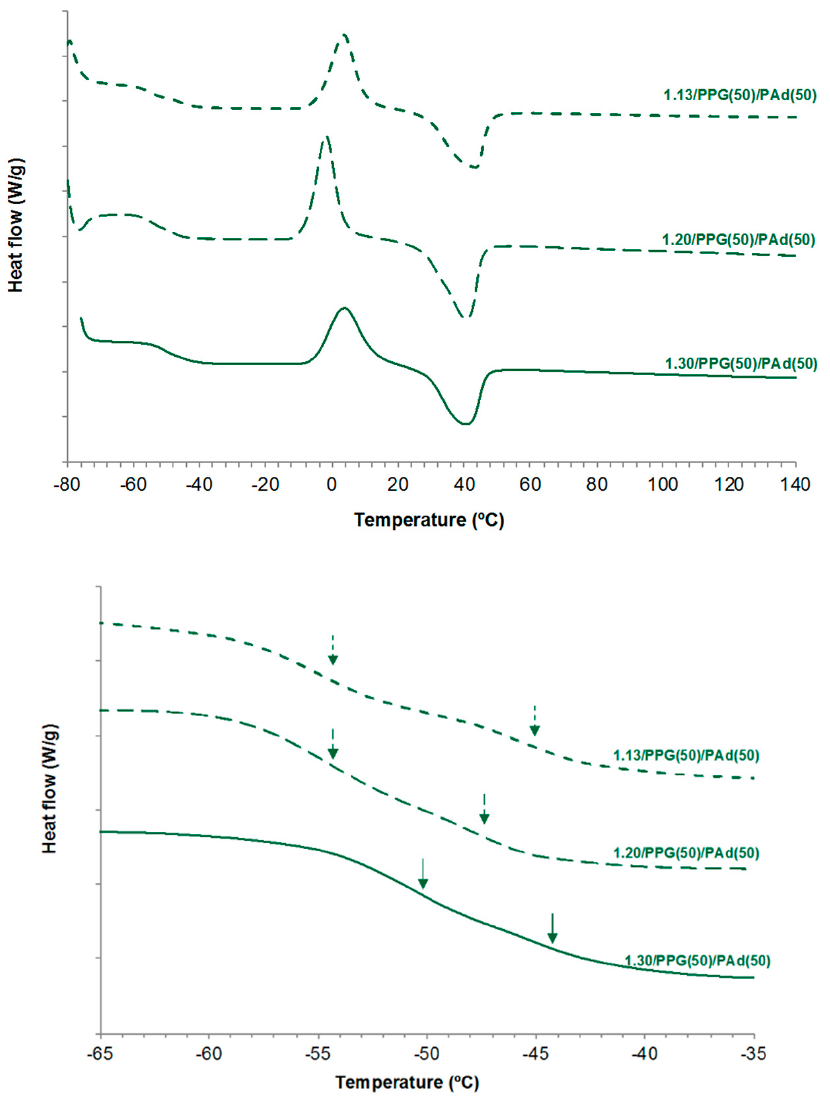
Figure 11. DSC traces of the TPUs synthesized with different NCO/OH ratios. Second heating run. Table 11. Thermal events from the DSC traces of the TPUs synthesized with different NCO/OH ratios. Second heating run. TPU T g,s1 ( ◦